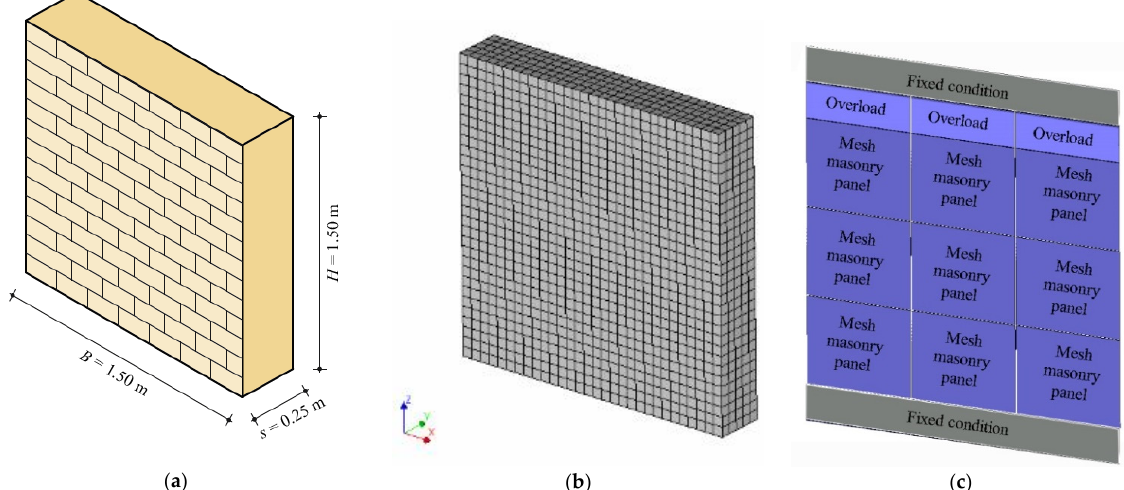
Figure 10. ( a ) Geometry of the masonry panel used for the parametric analyses and computational models: ( b ) FEM and ( c ) DMEM.